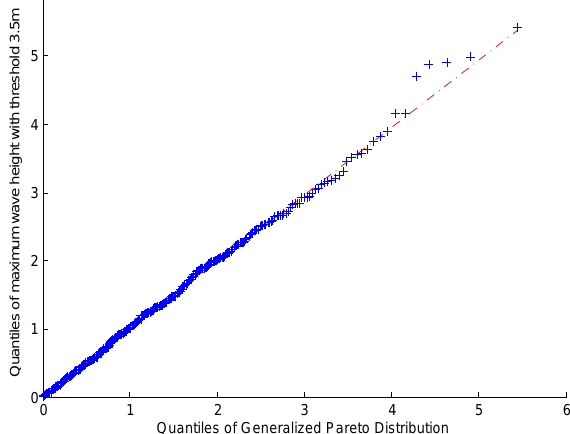
Figure 7. Q-Q plot of the fitted Generalised Pareto distribution to maximum wave height over 3.5 m